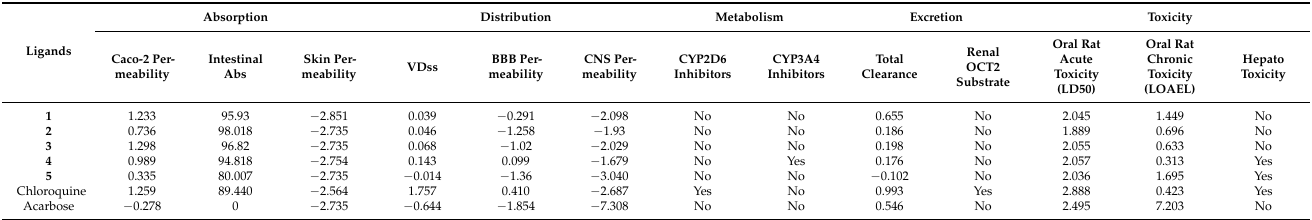
Table 8. ADMET properties by ProTox Online